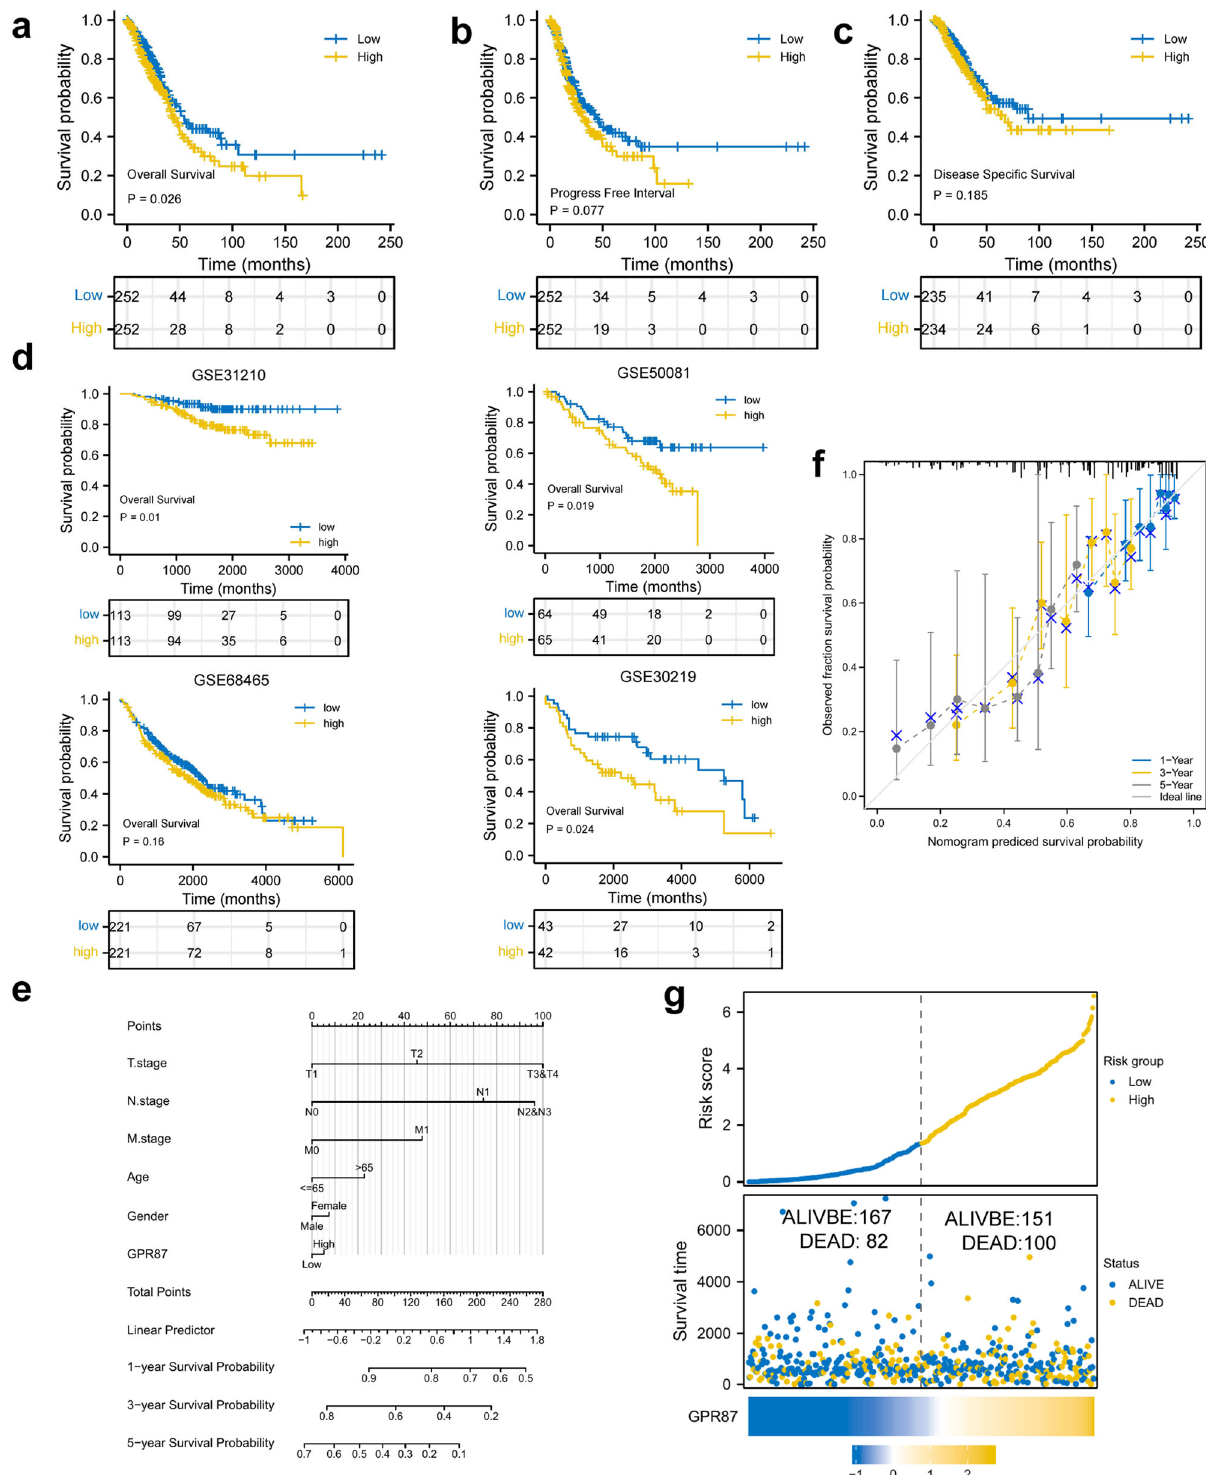
Fig. 4 Kaplan – Meier curves of GPR87 in LUAD patients. OS ( a ), disease-speci fi c survival ( c ), and progress-free interval ( b ) in the TCGA-LUAD dataset. d OS in the GSE31210, GSE50081, GSE68465, and GSE30219. e GPR87 was combined with other clinical factors to plot the nomogram and predict the prognosis of LUAD patients. f The calibration curve was drawn to verify the accuracy of the prediction model in predicting 1-, 3-, and 5-year survival rates. g Survival conditions of LUAD